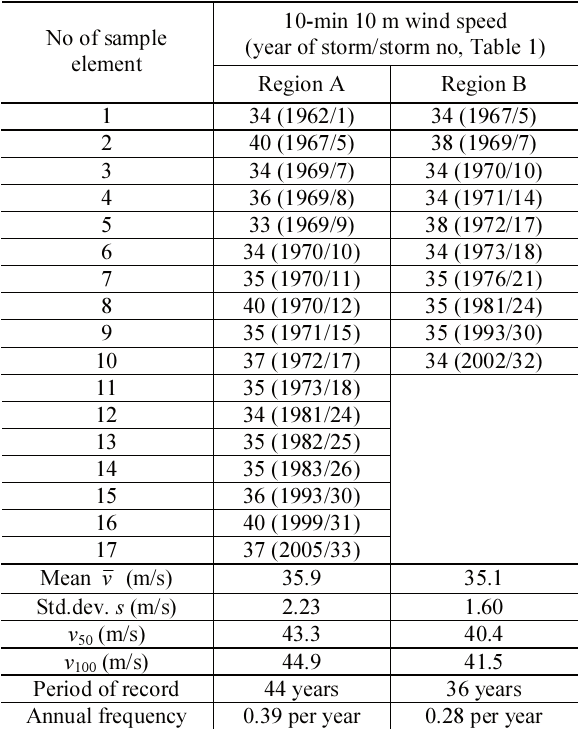
Table 5. Statistical samples of hurricane wind speeds (m/s) in the hurricane wind regions A, and B (Fig.